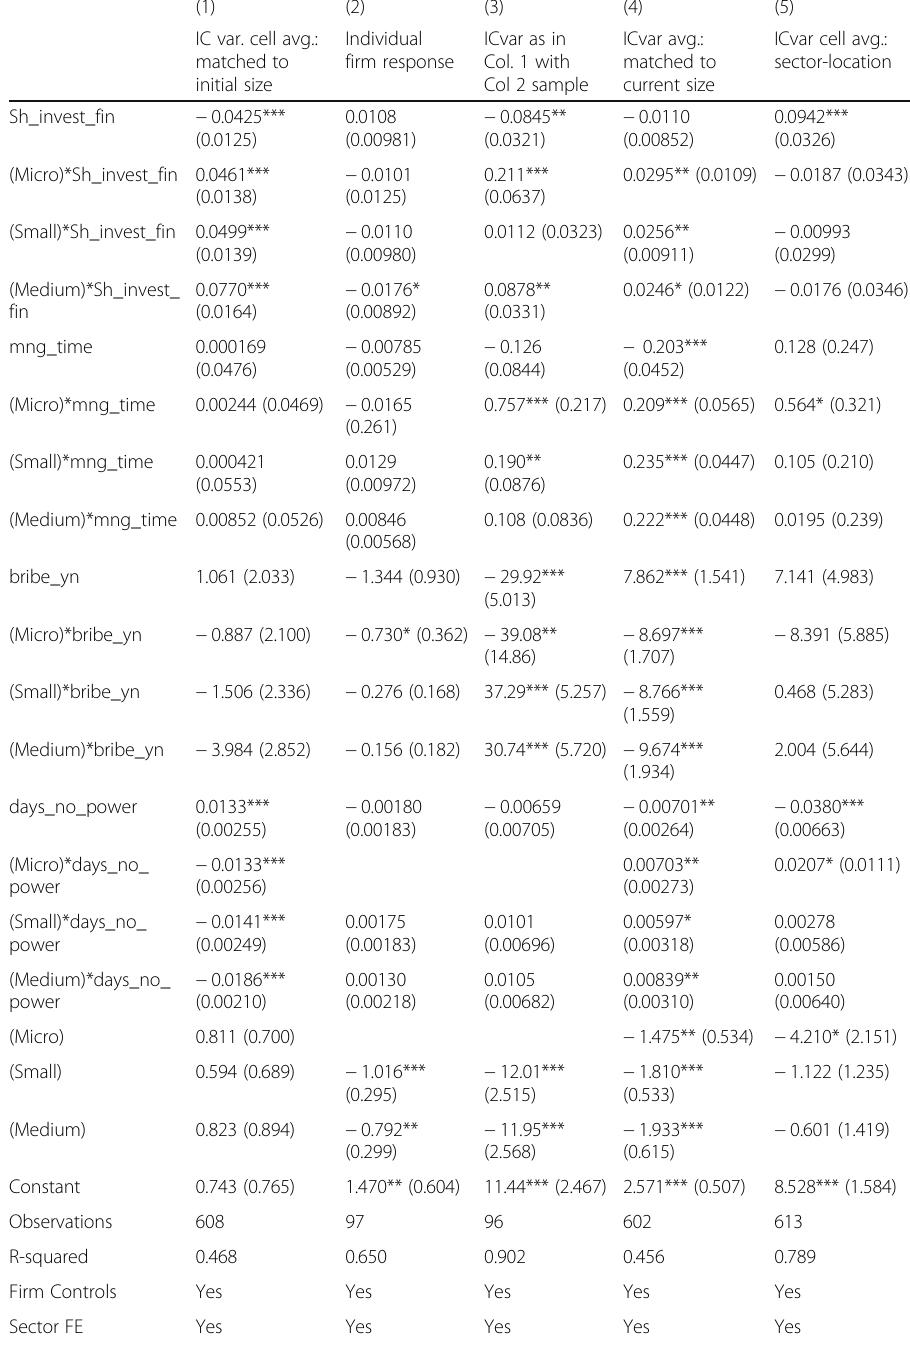
Table 4 Impact of finance and other investment climate on employment growth Sh_invest_fin − 0.0425***